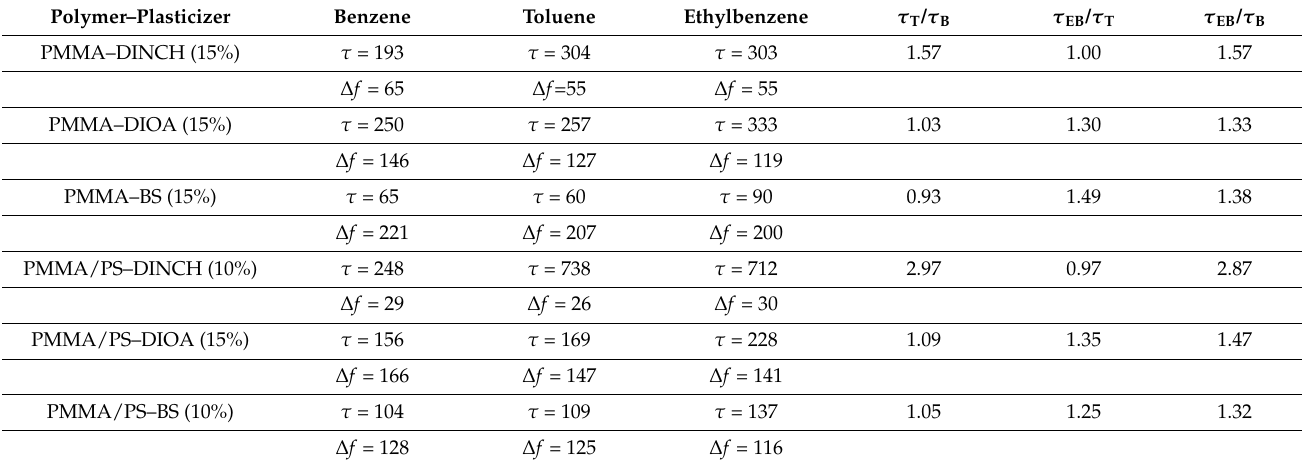
Table 8. τ (s) and ∆ f equil (Hz) for benzene, toluene, and ethylbenzene in various polymer–plasticizer coatings.